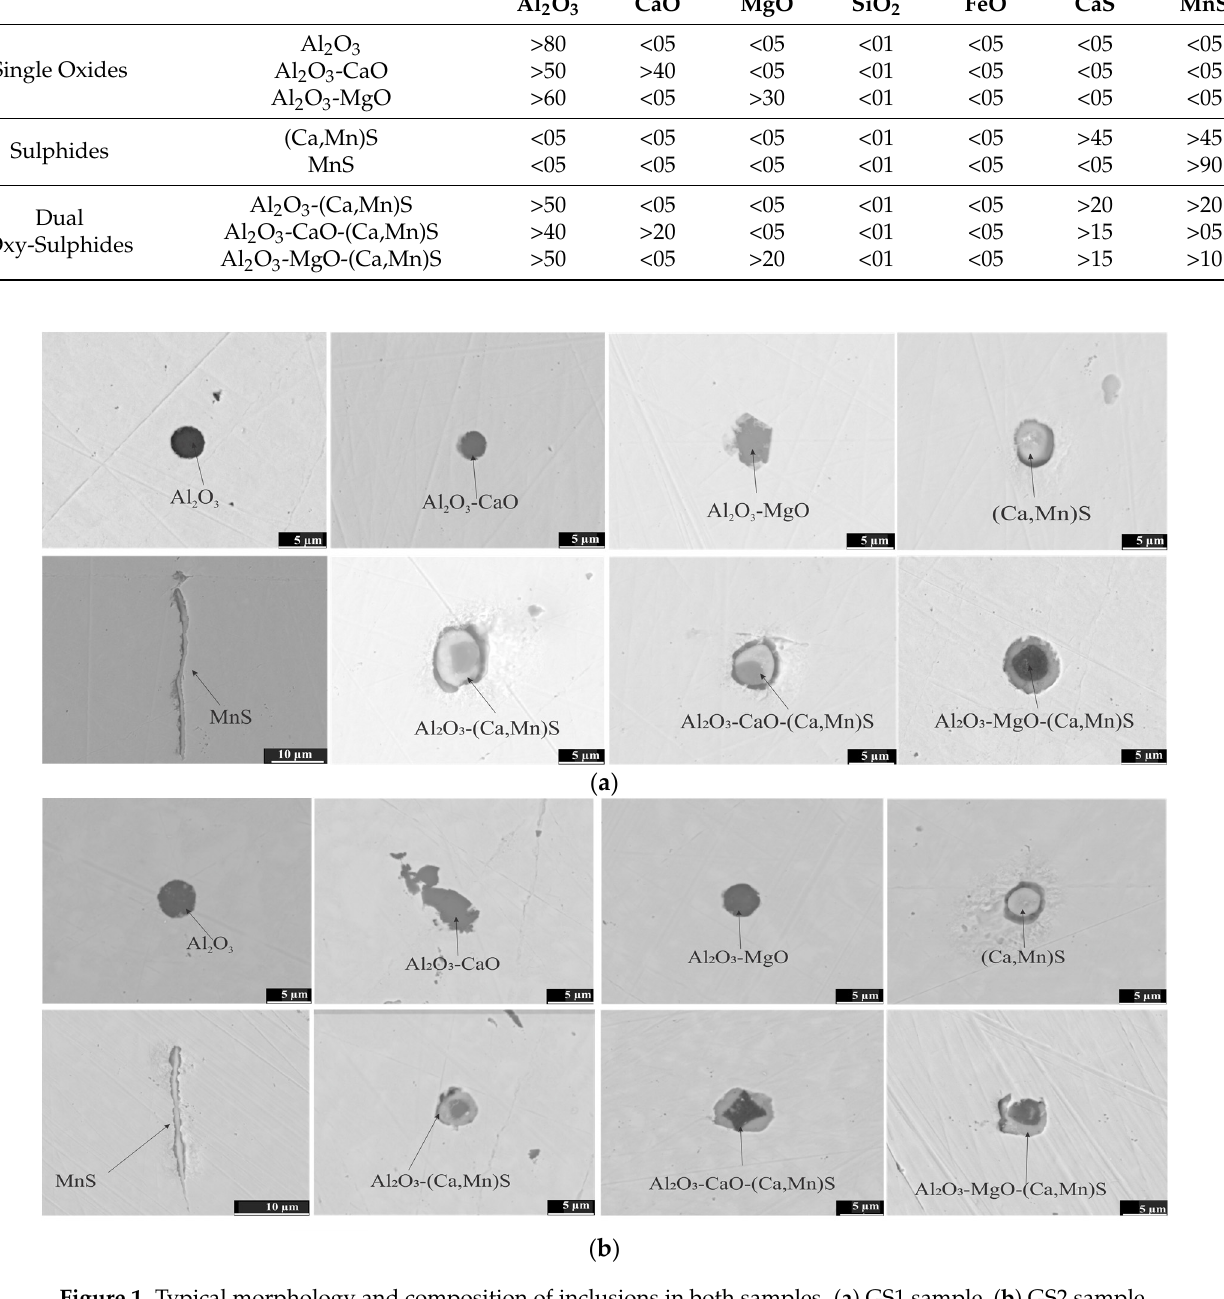
Table 2. Classification of inclusions in both samples based on the chemical compositions and morphologies. Inclusion Type